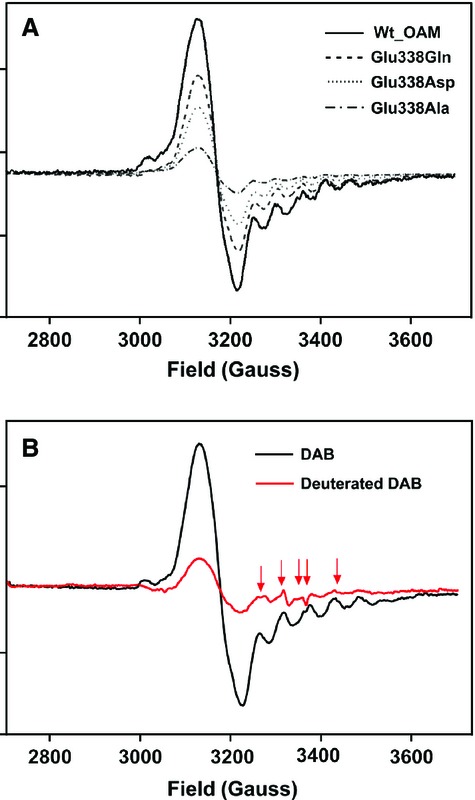
Continuous-wave EPR spectra of wild-type OAM and Glu338 variant enzymes. (A) EPR spectra showing the relative amount of paramagnetic species formed for wild-type OAM and variant enzymes in the presence of inhibitor DAB. (B) Perturbations in the CW EPR spectra of the E338Q variant when mixed with deuterated DAB ([2,4,4-2H3]-d-2,4-diaminobutyric acid) (spectrum shown in red, with arrows to indicate the corresponding spectral changes) instead of DAB (spectrum in black). The holoenzyme solution contained 250 μm OAM, 250 μm PLP and 250 μm AdoCbl in 100 mm NH4-EPPS buffer, pH 8.5. DAB (10 mm) was added to the holoenzyme, and samples were loaded into EPR tubes and frozen in liquid nitrogen after 5 min incubation.